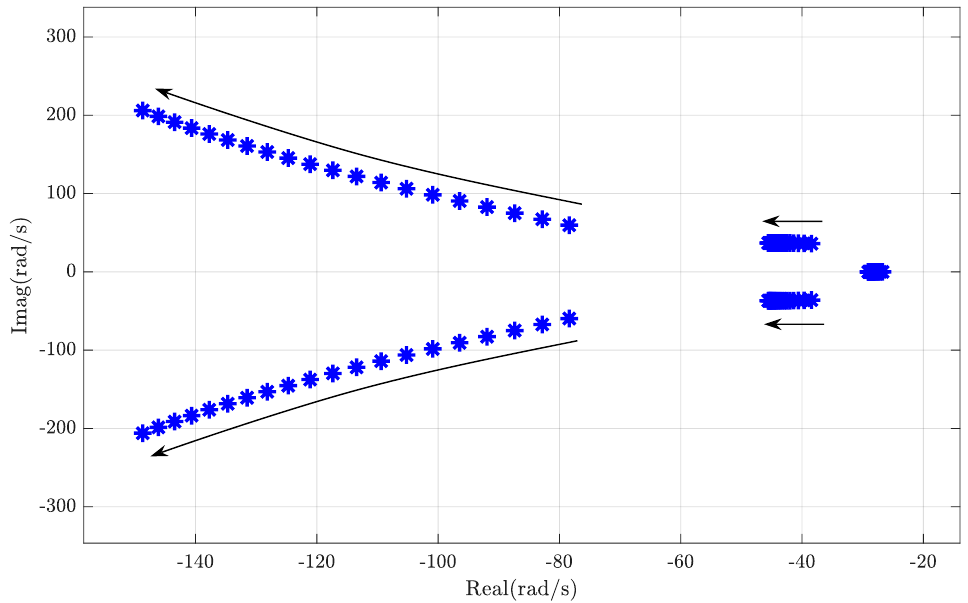
Figure 17. Pole displacement map in response to integral gain variation in VSC voltage control ( k iv 2 ) loops, 188 < k iv 2 < 560. Table 1. Parameters of the PVSC system under the study.